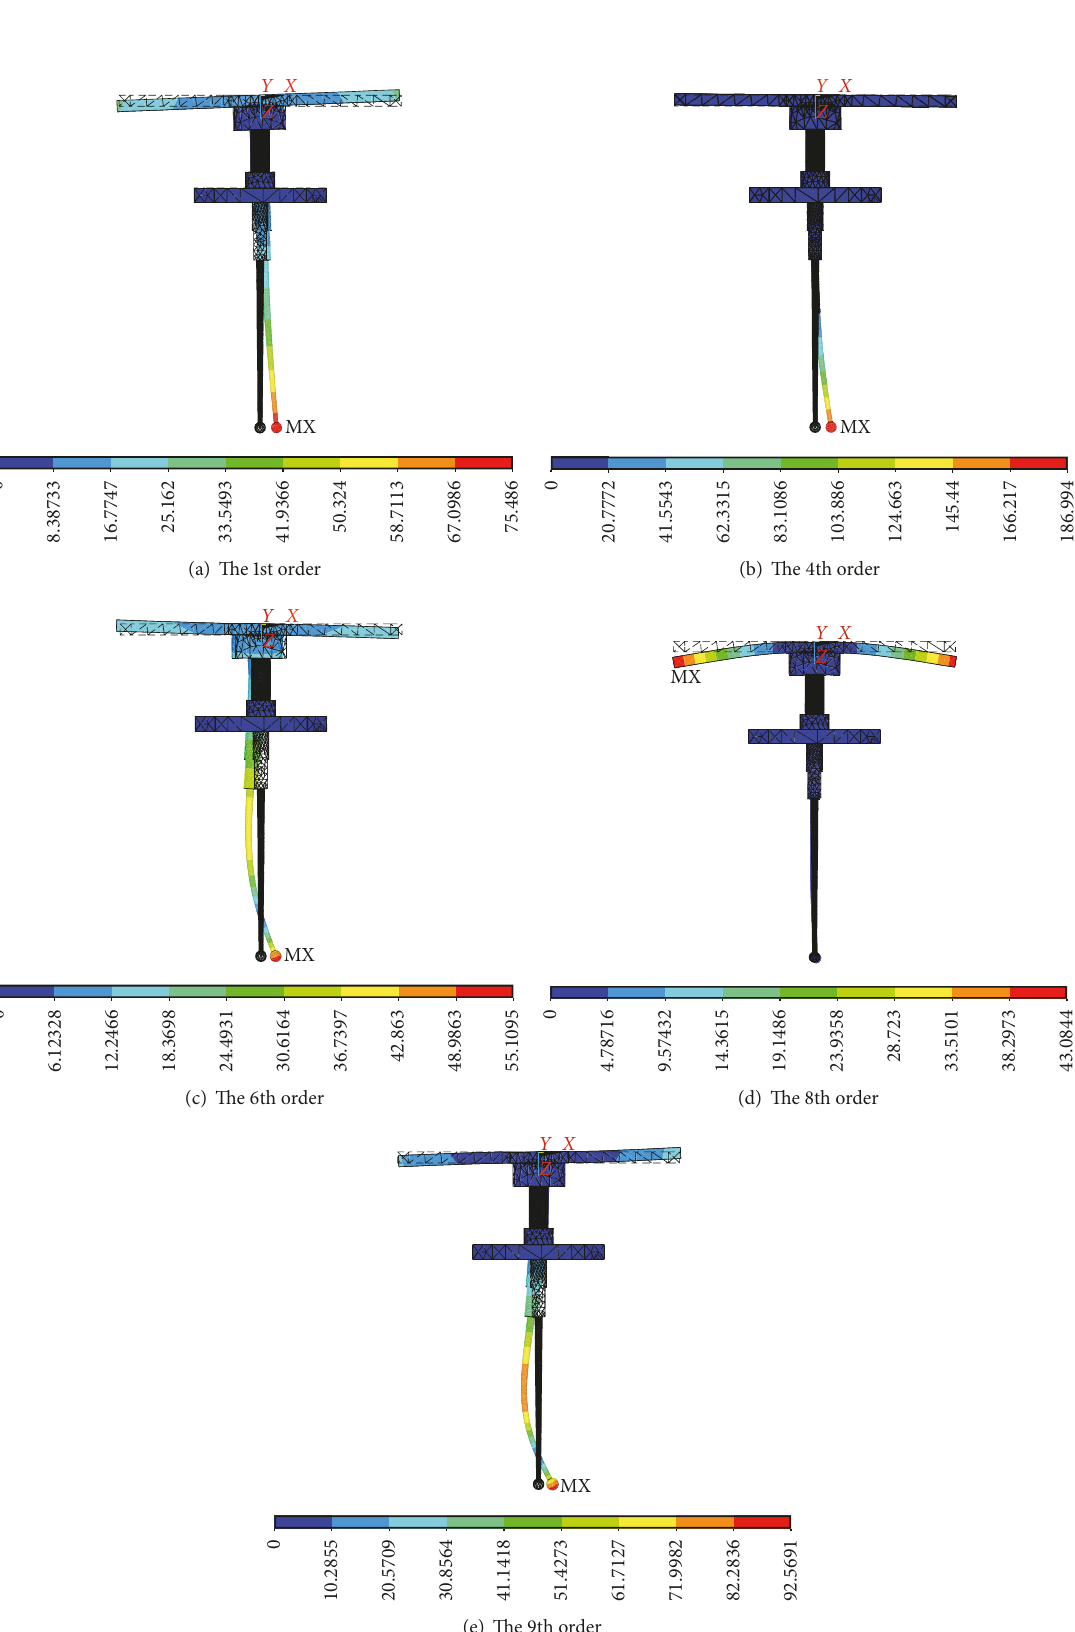
Figure 8: The vibration modes associated with the vibrations in the working